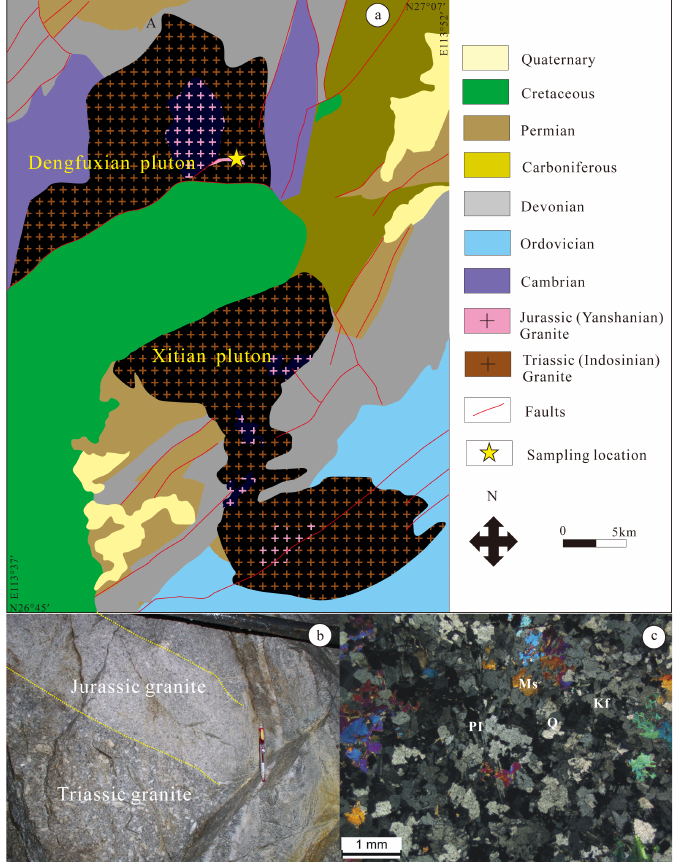
Figure 2. Geological sketch map of the Xitian and Dengfuxian plutons ( a ), modified from [67]; Out ‐ crop ( b ) and orthogonal polarizing micrograph ( c ) of the Dengfuxian Jurassic granite. The location of Figure 2a has been shown in Figure 1b.